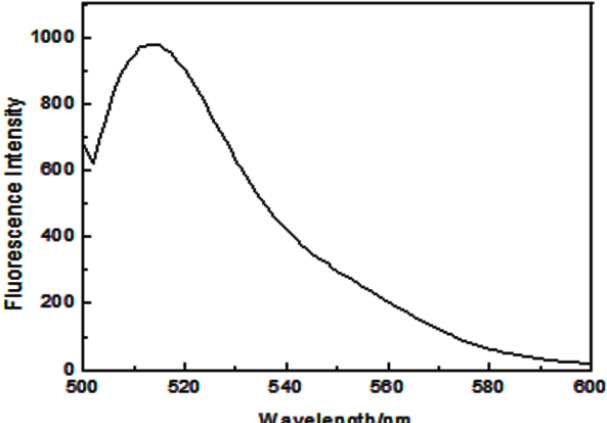
Figure 1. Fluorescence emission spectrum ( λ ex = 493.0 nm) of MIP modified with FITC in PBS (0.01 mol·L − 1 , pH = 6.8) solution.